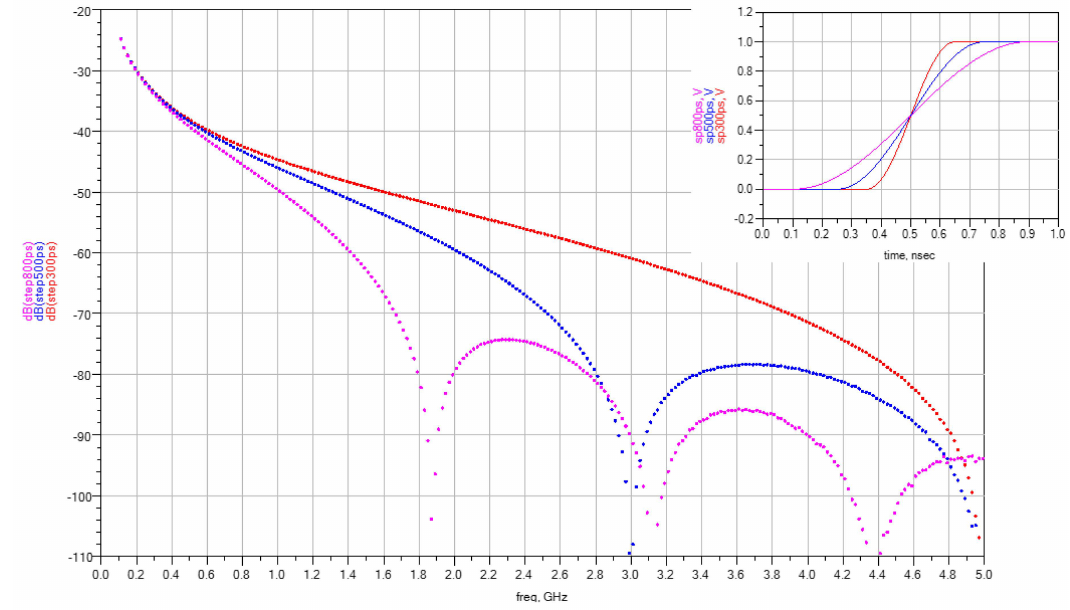
Figure 2. The spectra of 300–800 ps rise-time step pulses (repetition period = 100 ns, duty cycle =